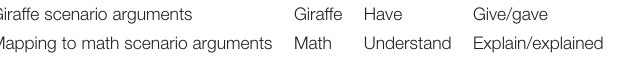
TABLE 2 | Semantic words in the giraffe complication-resolution scenario, and their replacements in the new “math” scenario. Giraffe scenario arguments Mapping to math scenario arguments